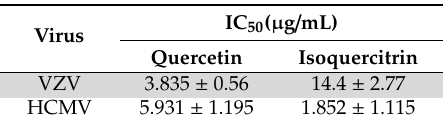
Table 1. Average 50% inhibitory-concentration (IC 50 ) values for antiviral activities of quercetin and isoquercitrin against VZV and HCMV.